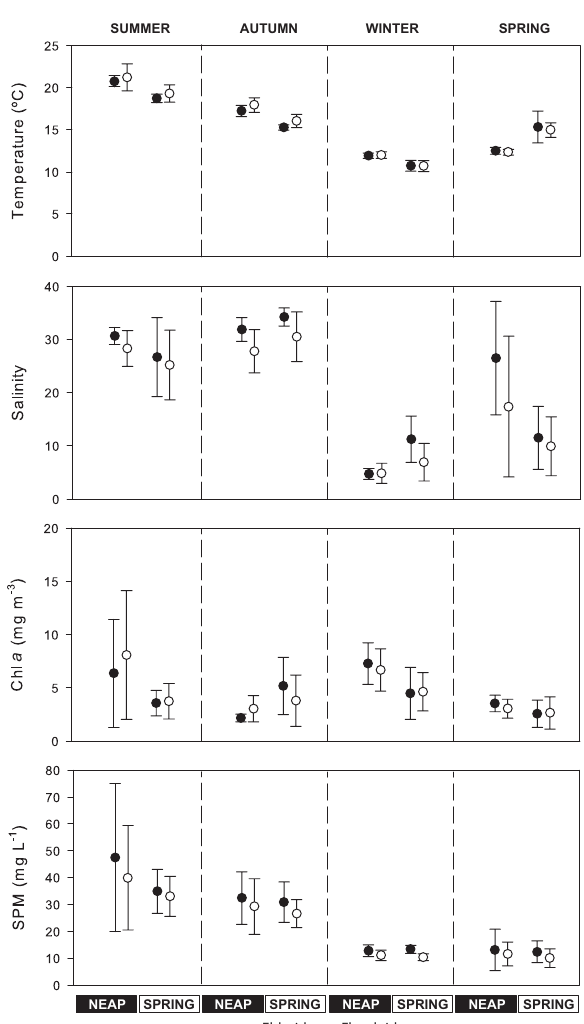
Fig. 2 . – Seasonal variation (mean±SD) in temperature (ºC), salin- ity, chlorophyll a (mg m 3 ) and suspended particle matter (SPM, mg L -1 ) measured during the high-frequency sampling